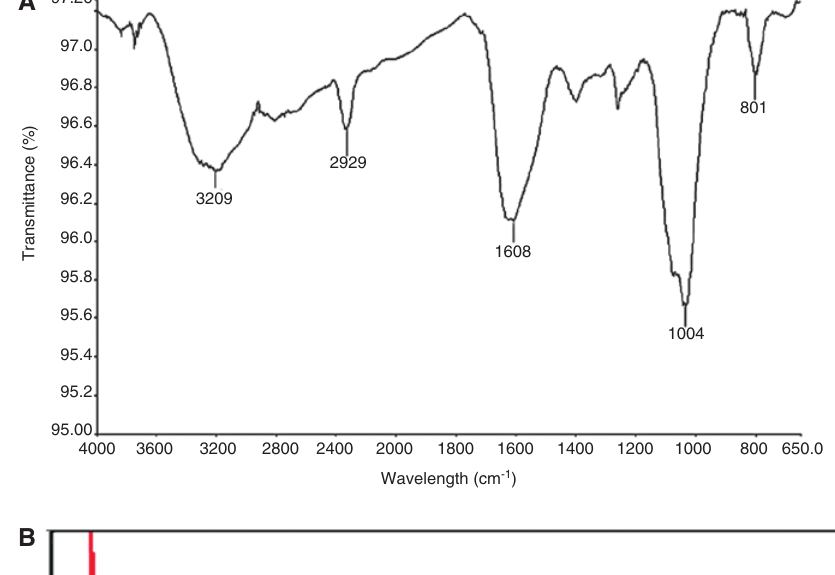
, 40 ° C, and 45 min) at the end of the reaction with the extract of deoiled 3 . (B) (1) AgNO solution, (2) DSP aqueous extracts, and (3) after 3 3